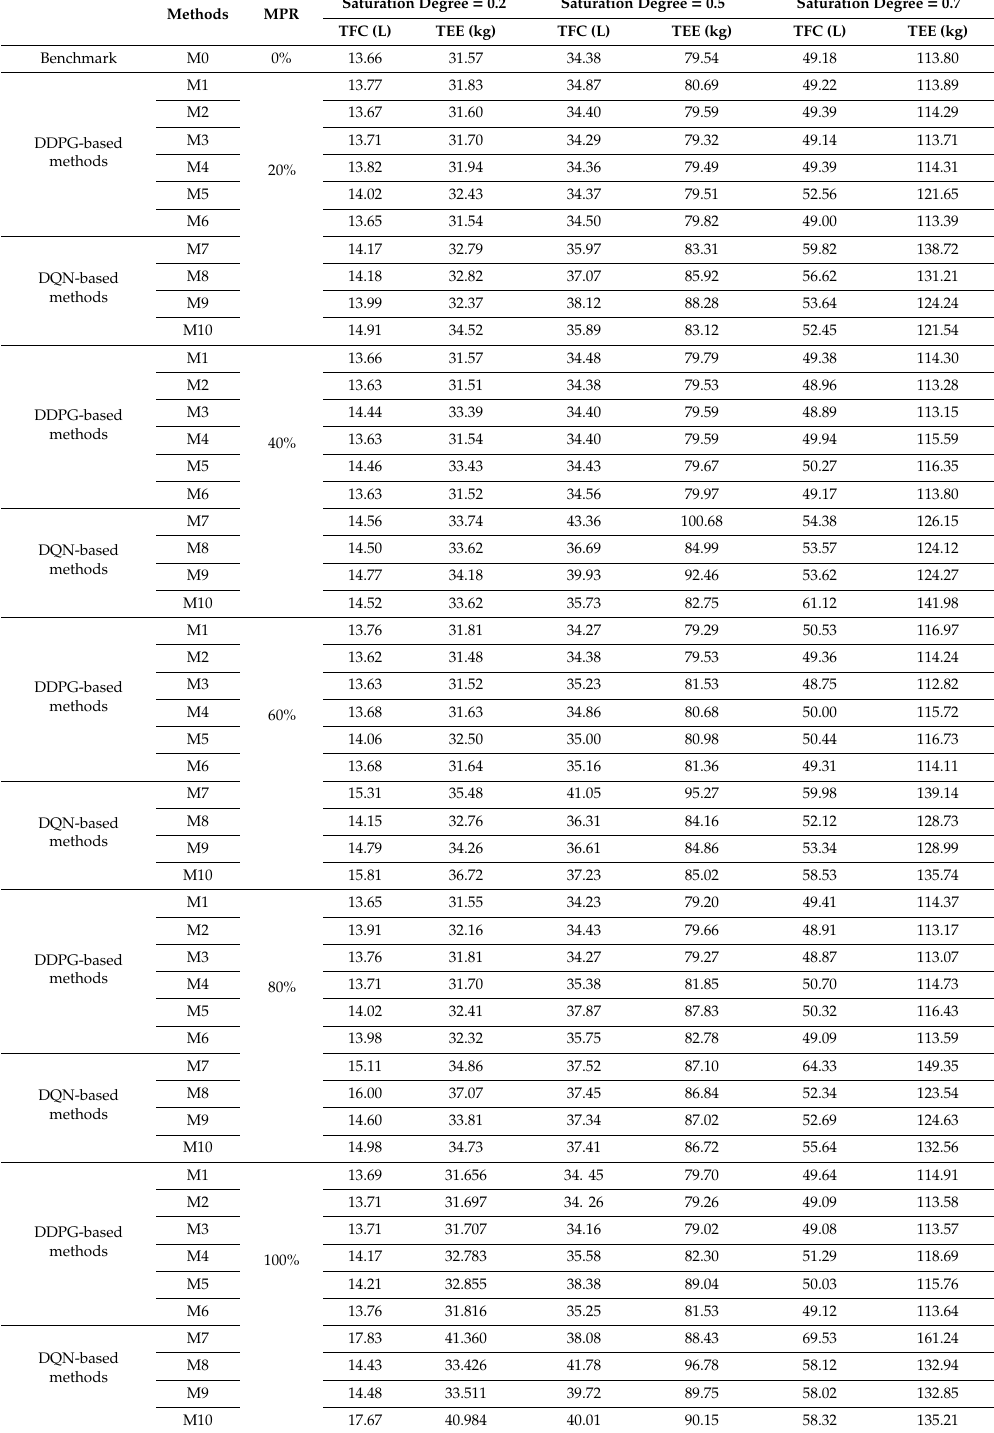
Table 6. Total fuel consumption (TFC) and total exhaust emission (TEE) values under saturation degrees of 0.2 / 0.5 /